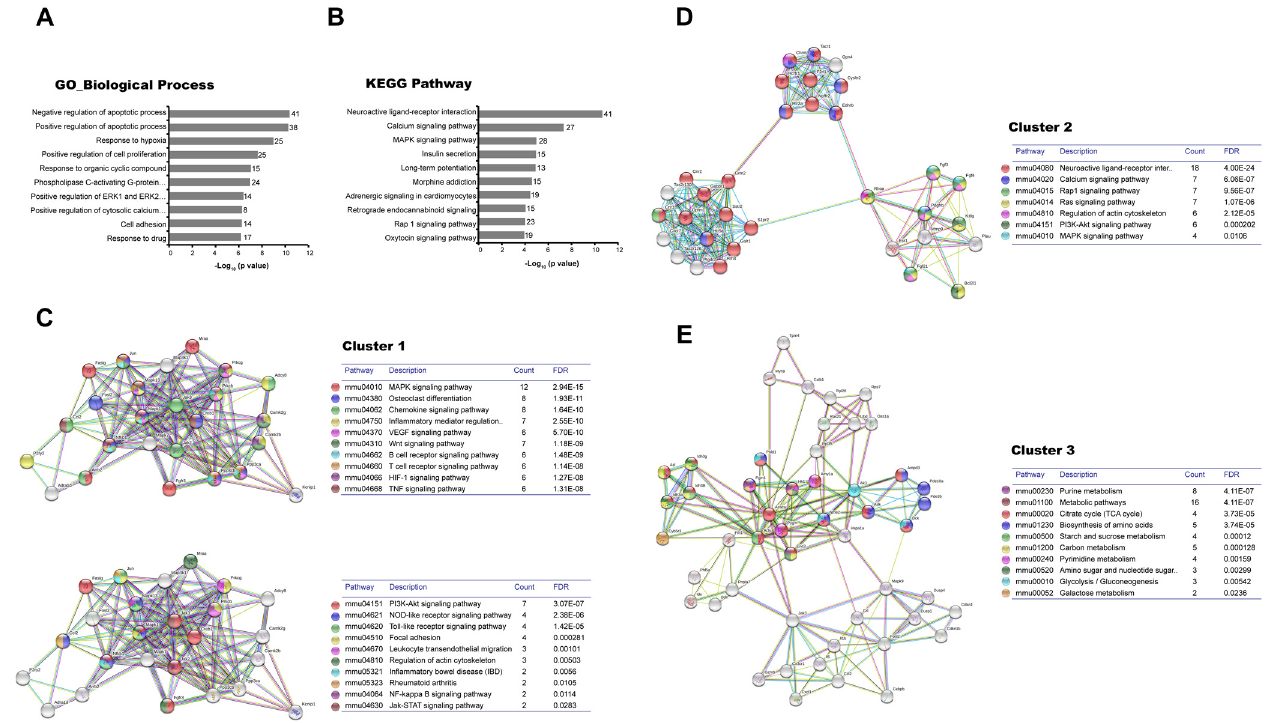
Figure 2. Transcriptomic dysregulation in hind paw footpads at 48 h post-Complete Freund’s Adjuvant injection. The lists of the differentially expressed genes (Z-score ≥ 1.5 SD) by CFA at 48 h were analyzed on the DAVID Bioinformatics Resources 6.8 (https://david.ncifcrf.gov/ accessed on 10 January 2023; ( A , B )), STRING 11.5 database (https://string-db.org/ accessed on 10 January 2023) and Cytoscape 3.9.1 platforms ( C , D ). The top 10 Gene Ontology (GO) Biological Process ( A ) and the Kyoto Encyclopedia of Genes and Genomes (KEGG) pathways ( B ) resulting from the DAVID database are shown in bar charts indicating the − Log10 ( p -value) of each GO and KEGG term. The number of genes involved in each term is shown on the right side of each bar. From the protein-protein interactions network of deregulated genes, the first ( C ), second ( D ), and third ( E ) clusters of sub-networks were obtained using the Molecular Complex Detection (MCODE) complement (cutoff = 0.4). The KEGG signaling pathways relevant to arthritis were selected (Tables) and marked with different colors. Line color indicates the type of interaction evidence. FDR: False discovery rate.